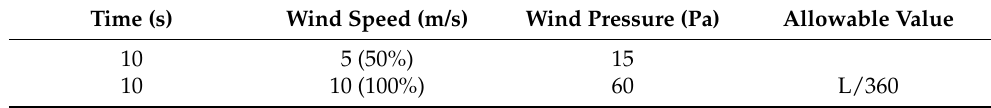
Table 5. Loading protocol #1 (L1).